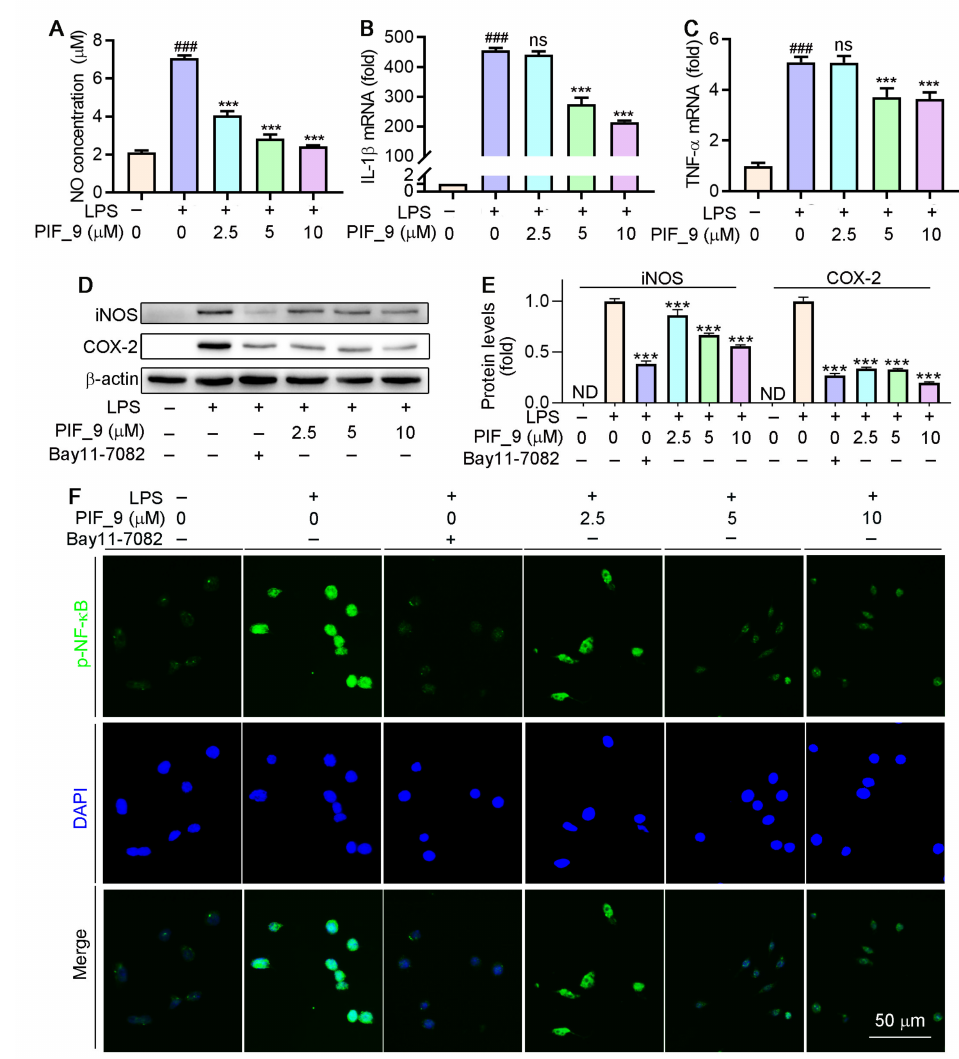
Figure 4. Compound PIF_9 inhibited LPS-induced inflammation in RAW264.7 cells by reducing NF- κ B activation. RAW264.7 cells in a 96-well plate ( A ) or a 6-well plate ( B – E ) or a 48-plate with coverslips ( F ) cultured in serum-free medium were pretreated with compound PIF_9 for 1 h, then co-treated with LPS (100 ng/mL) for 24 h. Medium NO levels were detected by NO assay kit ( A ). After treatment, total RNA was extracted; IL-1 β ( B ) and TNF- α ( C ) mRNA levels were analyzed